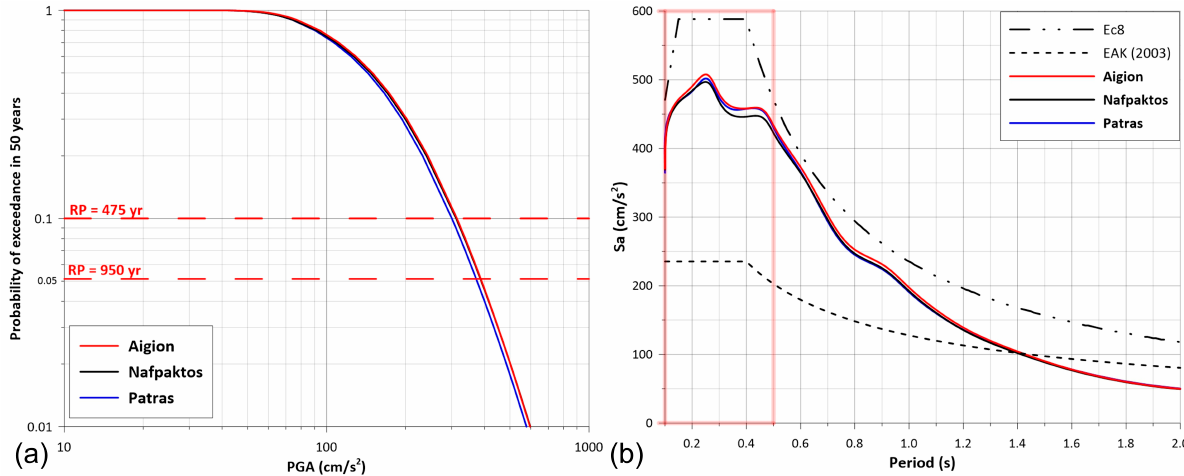
Figure 5. Hazard curves in terms of ( a ) PGA for Aigion, Nafpaktos, and Patras and ( b ) UHS for the aforementioned sites, alongside the Ec8 and EAK2003 response spectra. The red rectangle indicates the range of eigenperiods of most buildings in the study